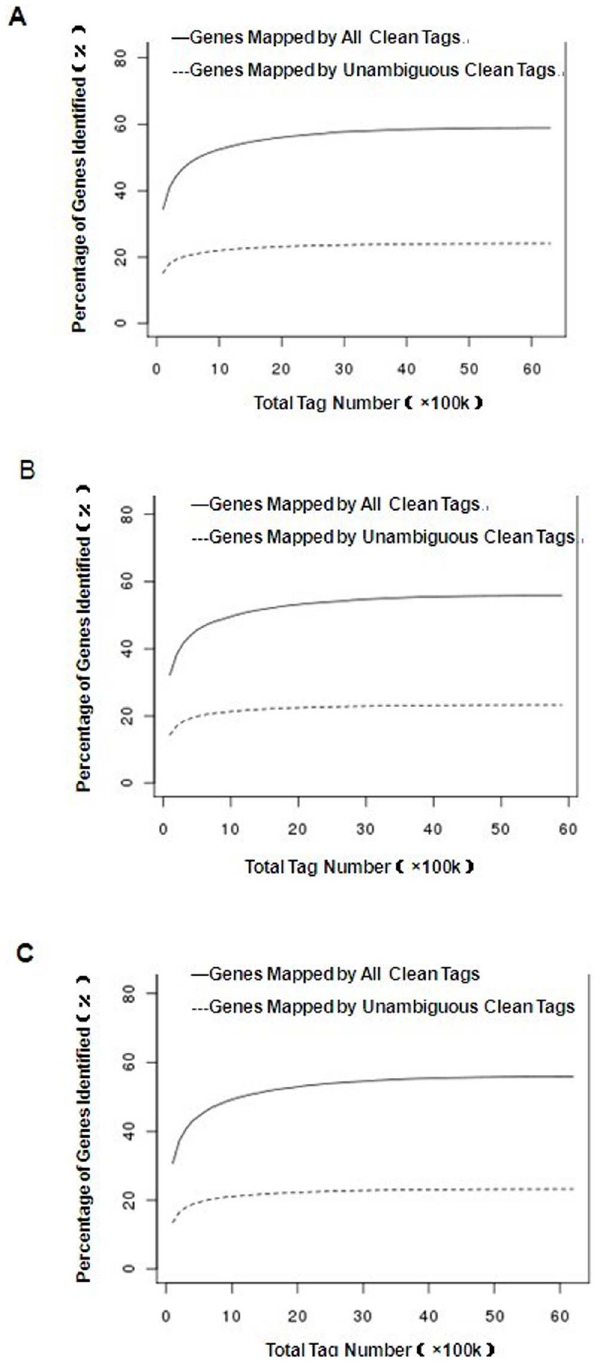
Figure 1. Saturation analysis of 2 35 d (A), 2 7 d (B) and + 3 d (C) libraries sequencing. ‘‘—’’ represents genes mapped by all clean tags. ‘‘---’’ represents genes mapped by unambiguous clean tags. The number of detected genes continued increasing as the total tag number increased. When the number of total tags reached 2M or more, the number of detected genes almost ceased increasing.